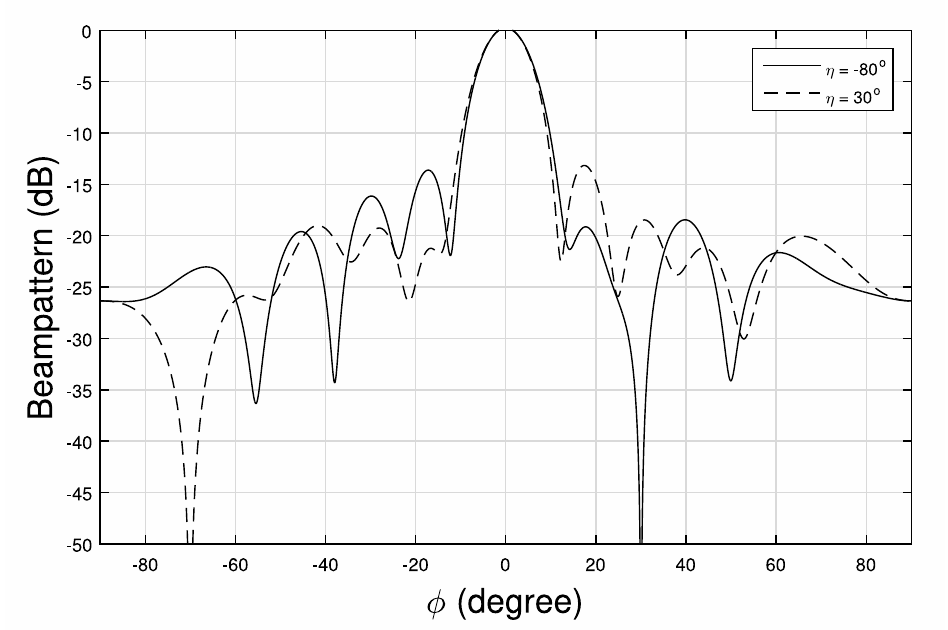
Figure 3. The resultant beam pattern for (1) θ = 90 ◦ , γ = 60 ◦ , η = − 80 ◦ ; (2) θ = 90 ◦ , γ = 60 ◦ , η = 30 ◦ .